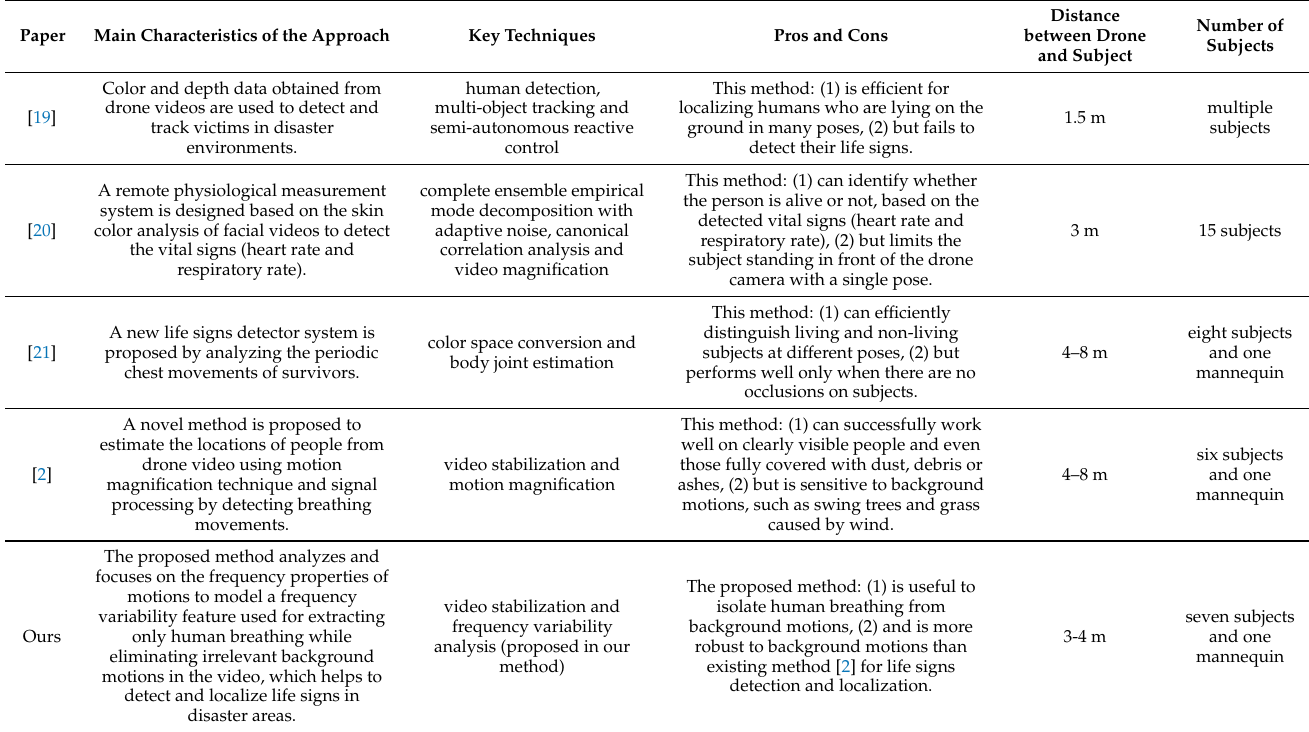
Table 1. Comparison among different drone-based approaches for life signs detection and